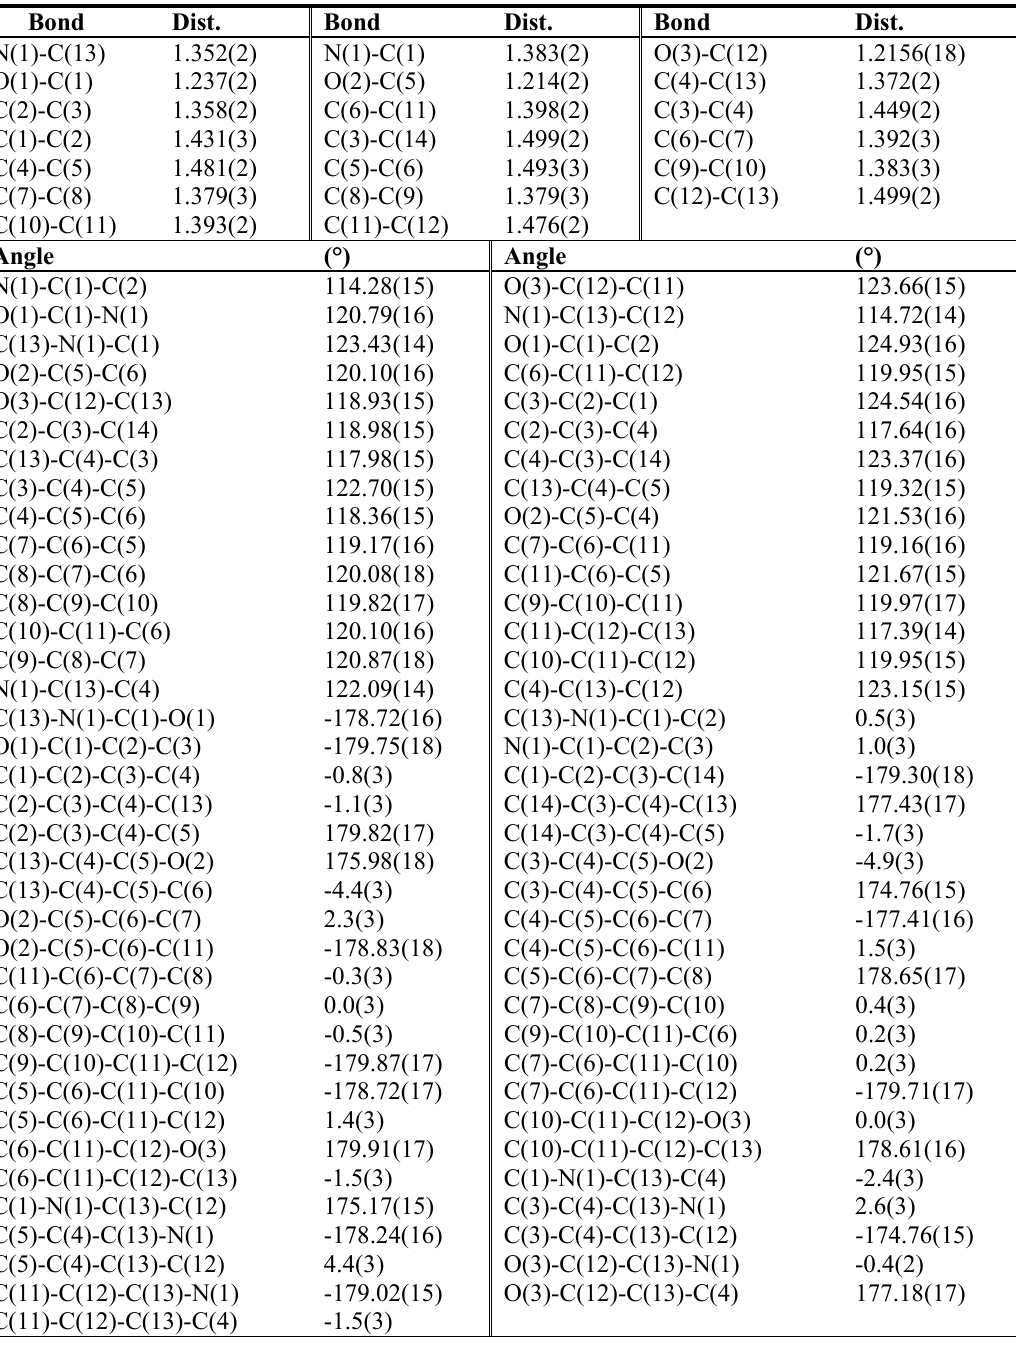
Table 2. Selected Bond Lengths (Å) and Bond Angles (°).